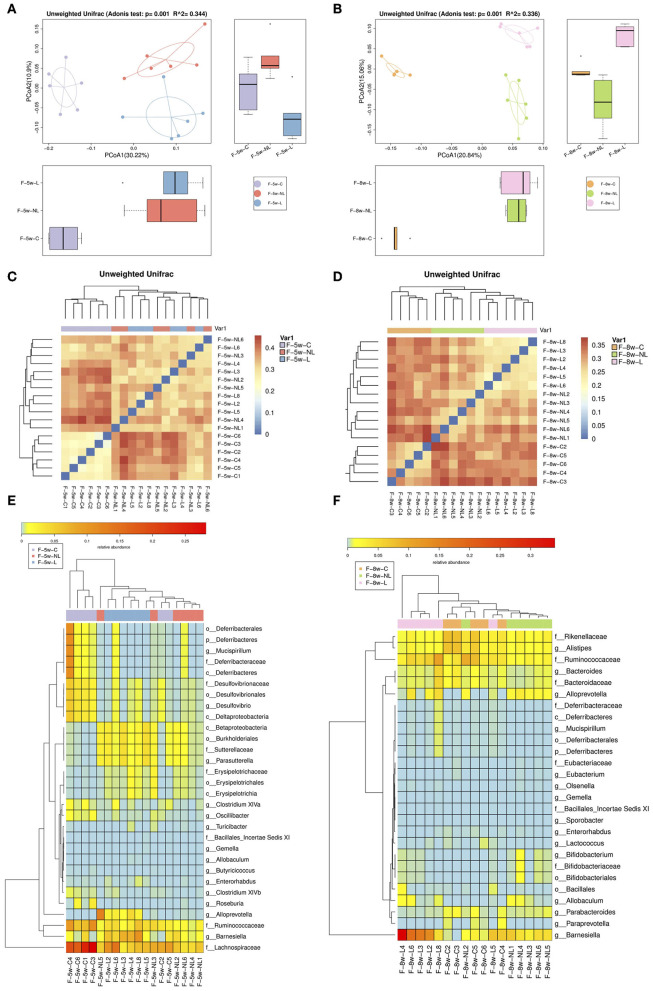
Comparison of gut microbiota among the non-surgical periodontal treatment group, the ligation group and the control group in 5 and 8 w. (A,B) Gut microbiota structure was shown by PCoA. (5 week: R2 = 0.344, p = 0.001; 8week: R2 = 0.336, p = 0.001, Adonis test). (C,D) Heatmap calculated from the unweighted UniFrac distance of the fecal samples of the three groups. (E,F) Heatmap cluster analysis of bacteria at all levels which have a contribution to group differences. ANOSIM, analyses of similarities; PCOA, principal coordinates analysis; F-8w-C, control group; F-8w-L, ligation group; F-8w-NL, non-surgical periodontal treatment group.